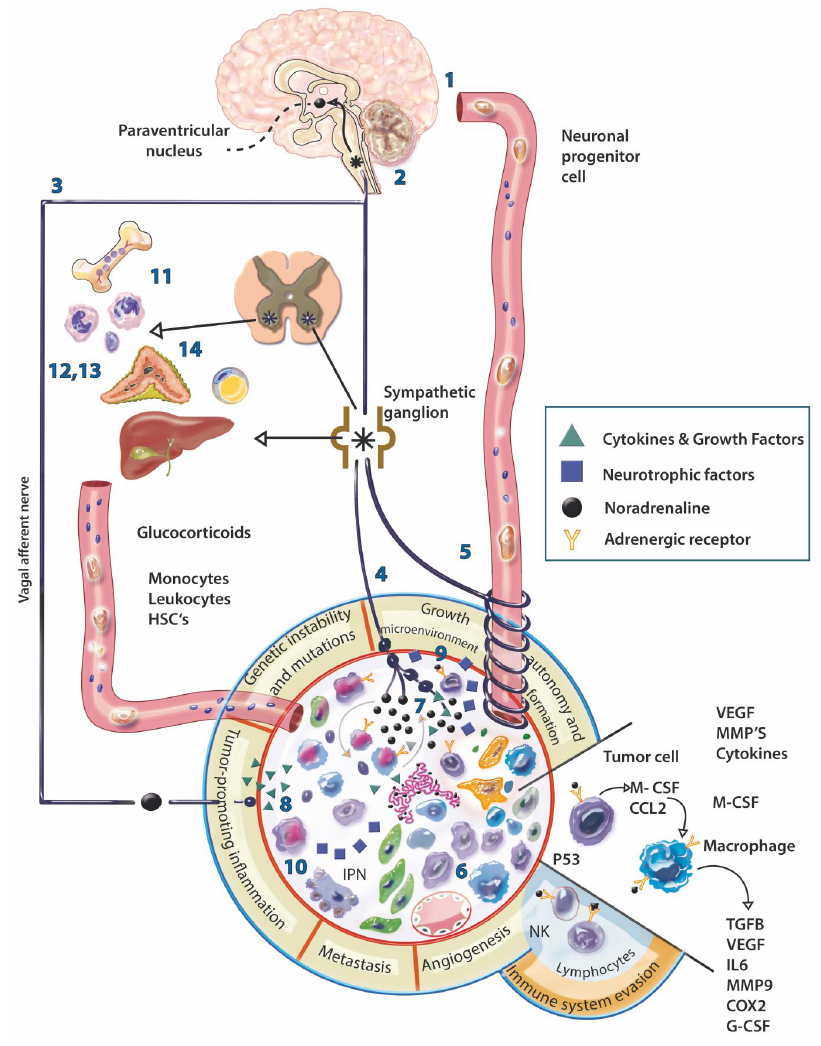
Figure 1. Physiological and neural modulation of the tumor. The communication of the nervous system (NS) with the tumor can be direct, through the hematogenous (1) or neural route (2), or indirect through the stimulation of other organs (3); this communication could be